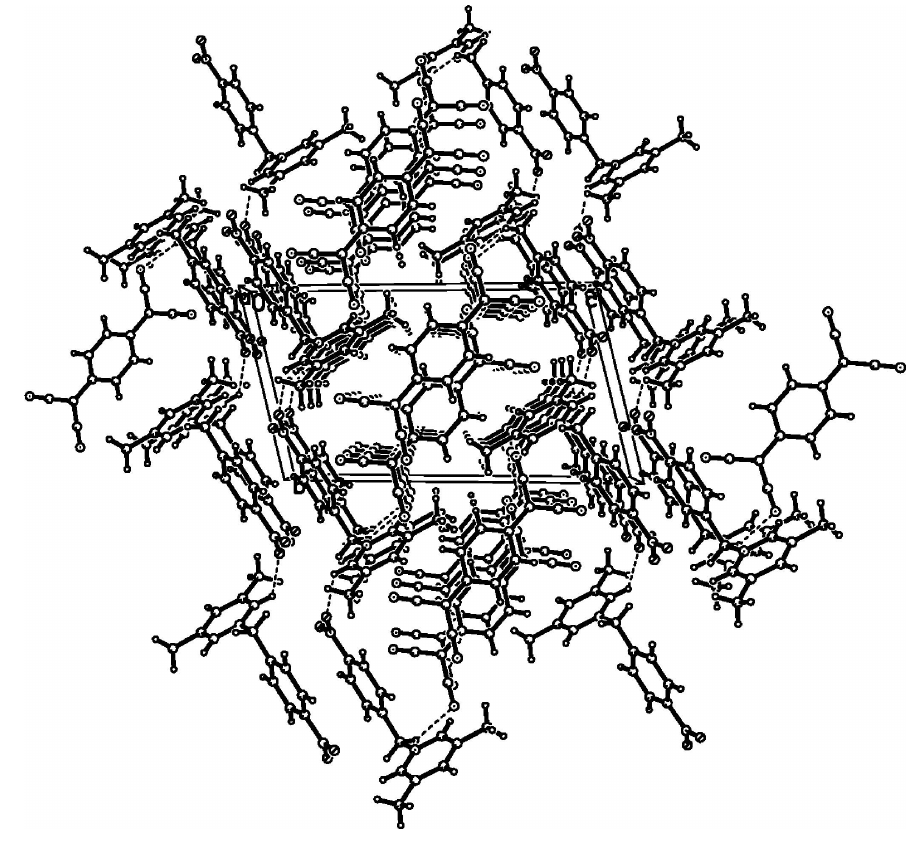
A packing diagram for (I). Hydrogen bonds are shown as dashed